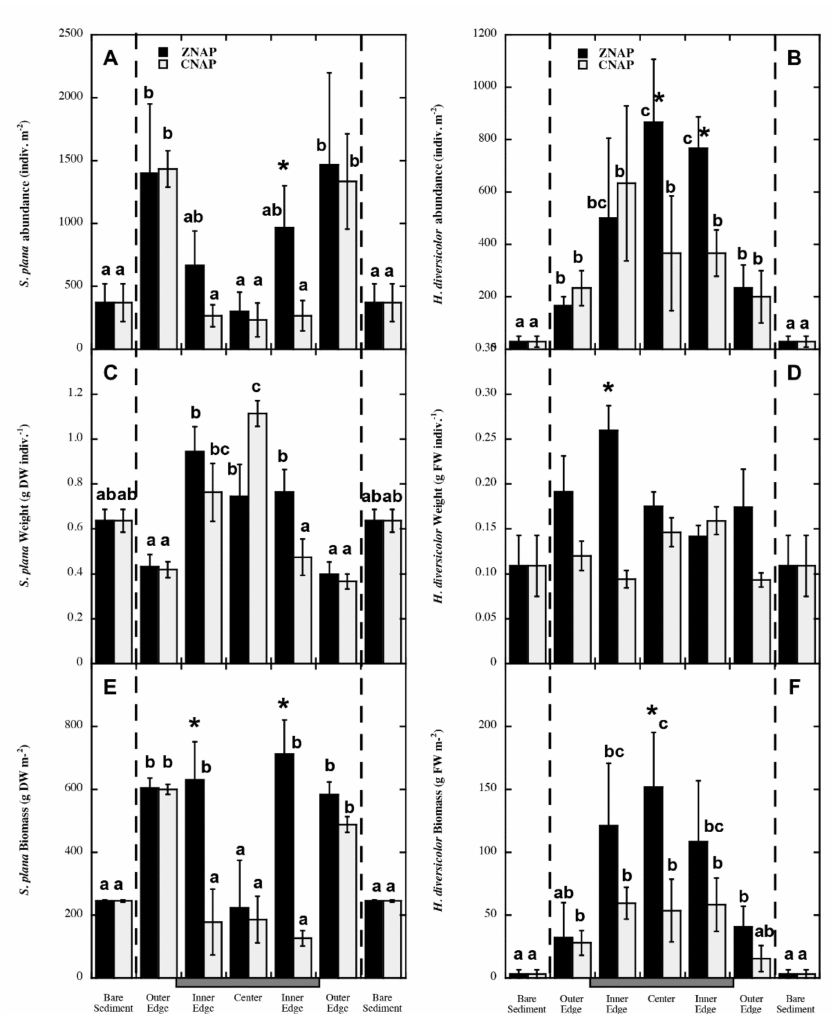
Figure 6. Recorded spatial gradients in ( A , B ) density, ( C , D )organism individual weight, and ( E , F ) to- tal biomass within the artificial seagrass patches for Scrobicularia plana ( A , C , E ) and Hediste diversicolor ( B , D , F ). The inset letters indicate significant differences between the different positions within each patch type (i.e., ZNAP or CNAP) using the Tuckey test. Inset asterisks indicate significant differences for the same position between the two patch types using the Tuckey test. The weight of S. plana included the shell and the soft tissues and is given in dry weight, while H. diversicolor is expressed as fresh weight. Data are represented as mean ±